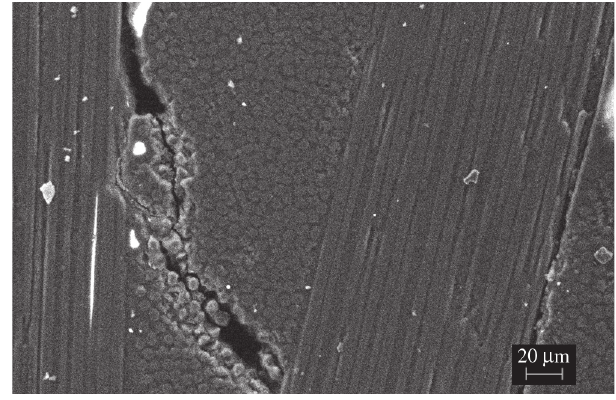
Figure 5. Fractograph of fiber/matrix interface of dry carbon/epoxy laminate. Figure 8. Fractograph of interface region of dry carbon/BMI fabric